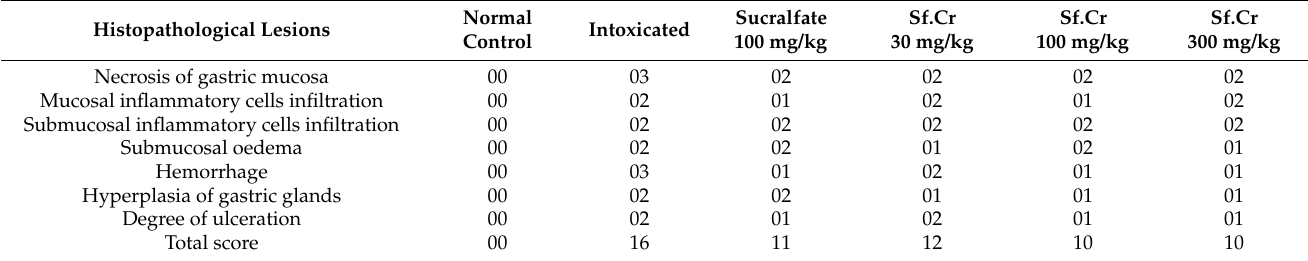
Figure 5. Histomicrographs of the rat stomach with H & E stain at magnification of 400X (scale bar: 100 µ m). Control group ( a ) shows normal morphology and no visible signs of inflammation; intoxicated group ( b ) showing several inflammatory changes including bloody spots (arrow), oedema (arrowhead), and polymorphic nuclear cell infiltration (*). The stomach mucosa and submucosa showed fewer sings of inflammation when treated with sucralfate however infiltration and bloody spots are visible ( c ) and Sf.Cr showed amelioration of stomach tunics in a dose dependent manner with inconspicuous inflammatory changes ( d – f ). Table 2. Effect of Sf.Cr and sucralfate on histomorphology of ethanol-induced gastric ulcer